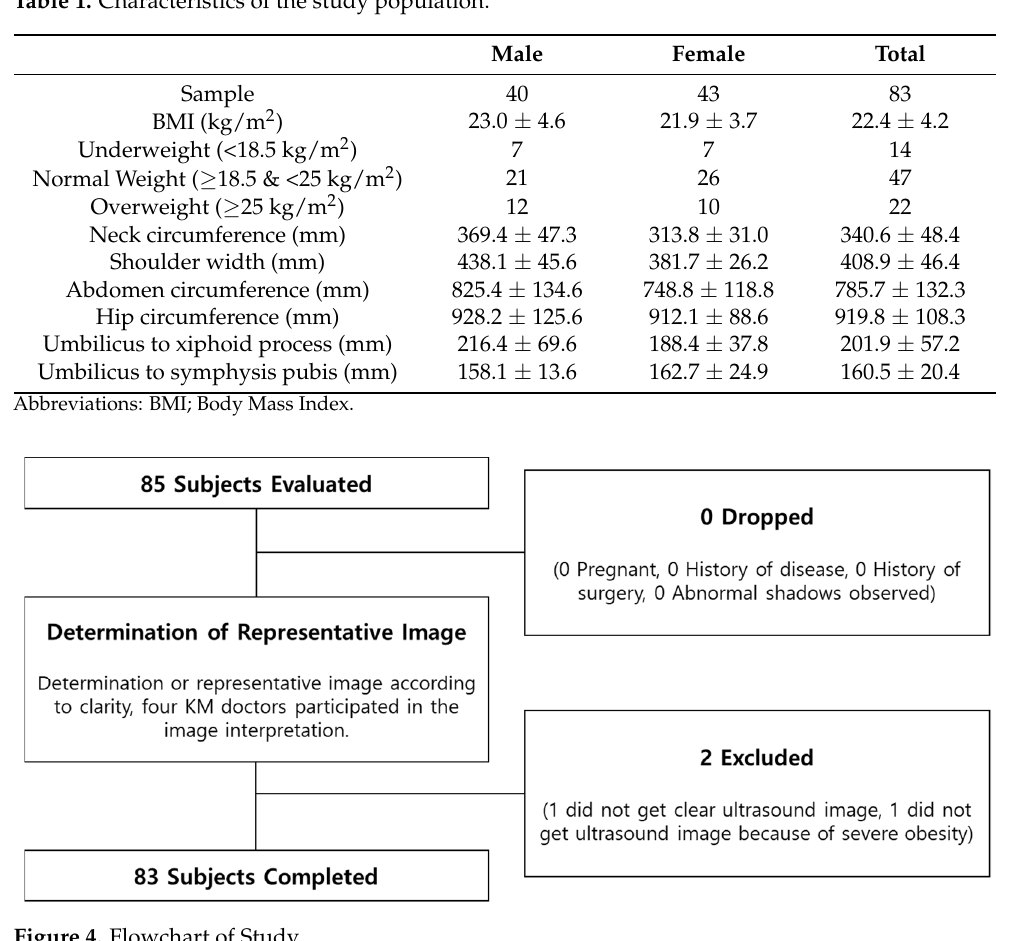
Figure 4. Flowchart of Study.